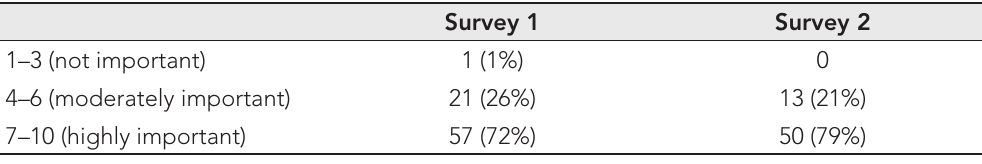
Table 3: Importance of giving aid, clustered responses